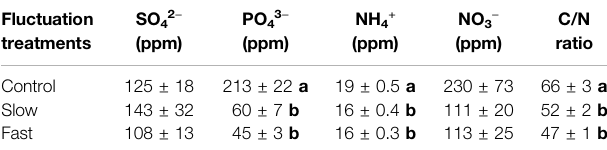
TABLE 1 | Chemical properties of Sphagnum living layer. Letter denotes statistically signi fi cant differences between treatments (Mean ± Standard Error, n (cid:2) 12, p <